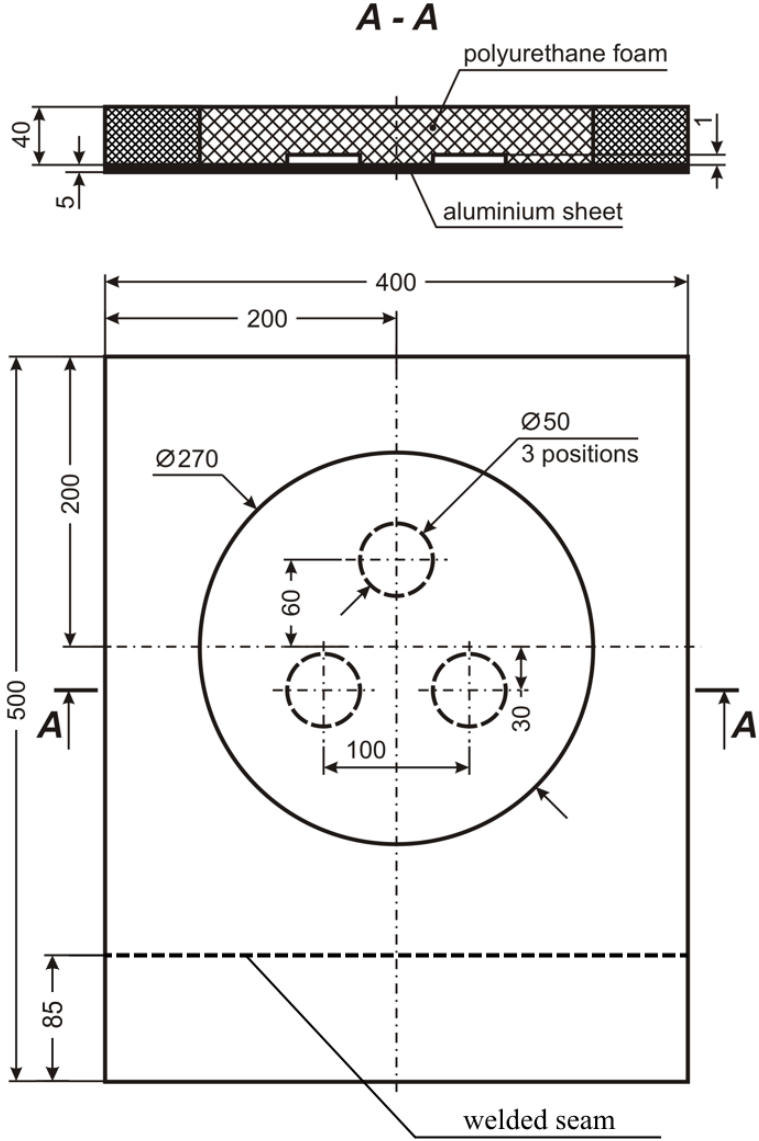
Figure 24. Mechanical drawing of composite mock insulation with three artificial defects. When this blind sample arrived at the laboratory, scans were carried out with the HSR at three frequencies: 7 GHz, 15 GHz, and 22.5 GHz. The HSR images are shown in Figure 25 [108,109]. As expected from theory, the spatial resolution improves with increasing frequency (while attenuation also increases). At 7 GHz, it is not possible to detect the three intentional defects. Instead, a geometric pattern of reflections from the edges of the sample dominates the image. However, the flaws are readily detectable in the 15 GHz and 22.5 GHz MW images. In addition, at higher frequencies, a weld bead in the aluminum substrate is visible. In the 22.5 GHz image, the reconstruction algorithm provides strong suppression of the edge effects, and while the intentional defects and internal structure of the sample are clear, there is also a surprise. Targets 1 and 2 on Figure 25 are imaged by the 22.5 GHz HSR but are not intentional anomalies. These are defects in the foam that were not intended by, nor known to, the fabricator. This experiment highlights that manufacturing procedures, even if carried out by qualified personnel and in specialized laboratories, are not free from unintentional defects that can be detected by HSR scans with sufficiently high frequency and